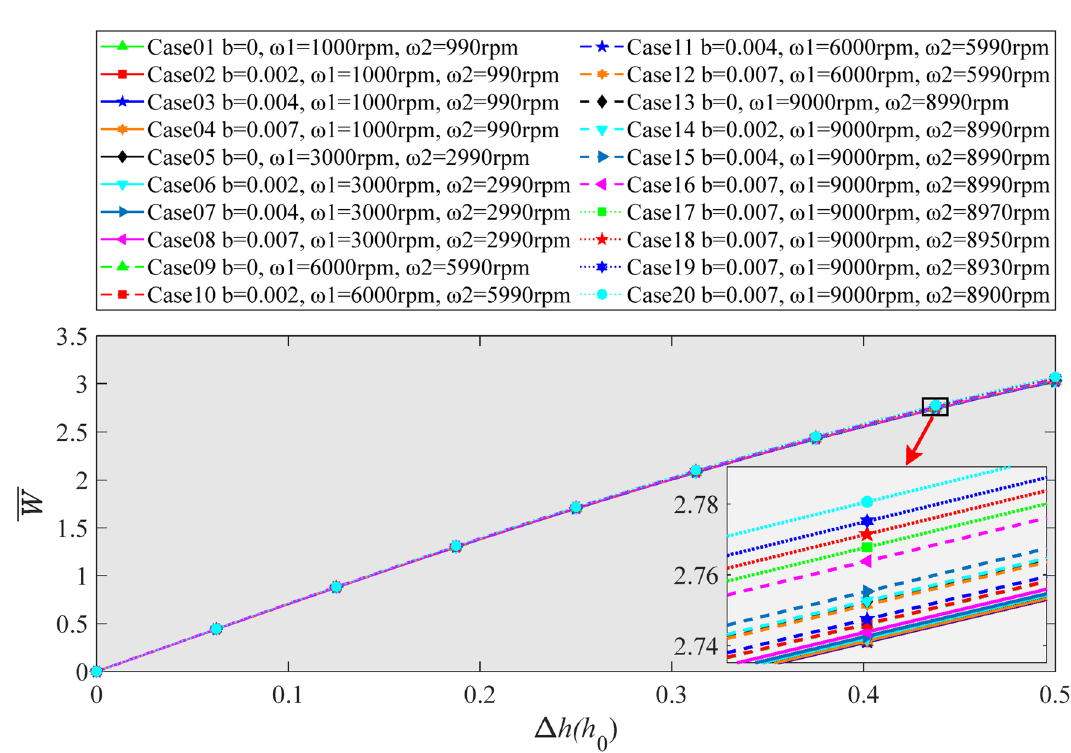
Figure 15. Influence of boundary slip on bearing capacity (Operation in dual drive differential